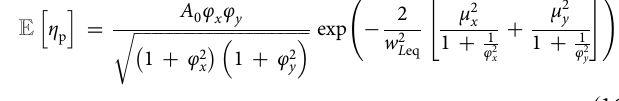
¼ w L eq ¼ w L eq and φ are the ratios between the where φ x y 2 σ x 2 σ y equivalent beam-width and the beam-jitter variances for the horizontal x and vertical y directions, respectively. For strong pointing errors, i.e., σ x , σ y → ∞ , we then have φ x , φ y → 0, and vice versa for weak pointing errors. From this relationship and Eq.